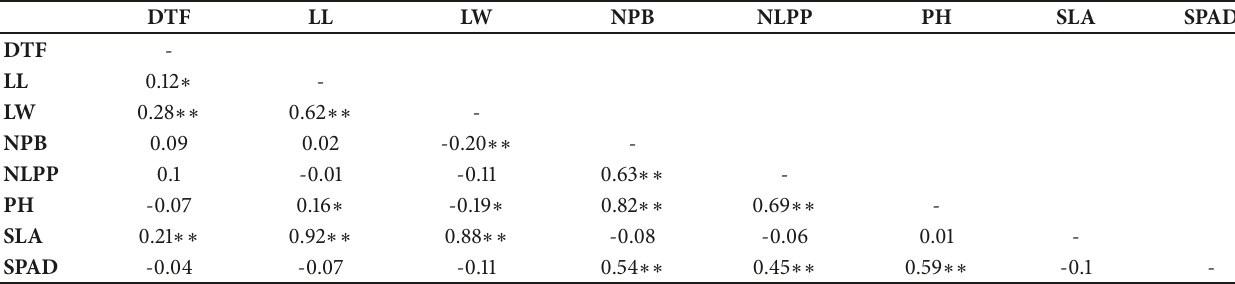
Table 6: Correlation in combined seasons.